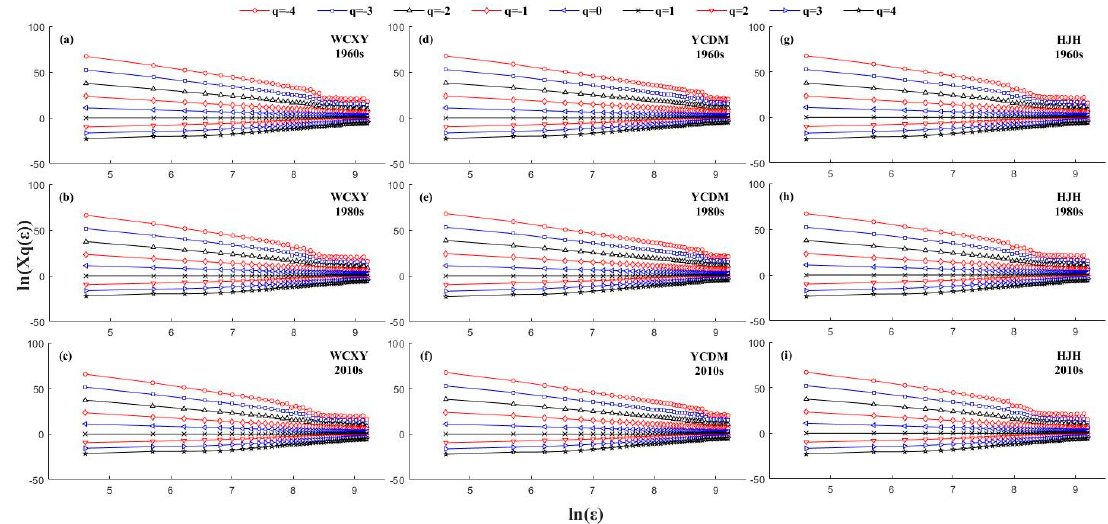
Figure 3. The ln( X q ( ε ) )~ln( ε ) relationships of Wuchengxiyu (WCXY), Yangchengdianmao (YCDM), and Hanhjiahu (HJH) in 1960s–2010s under q from –4 to